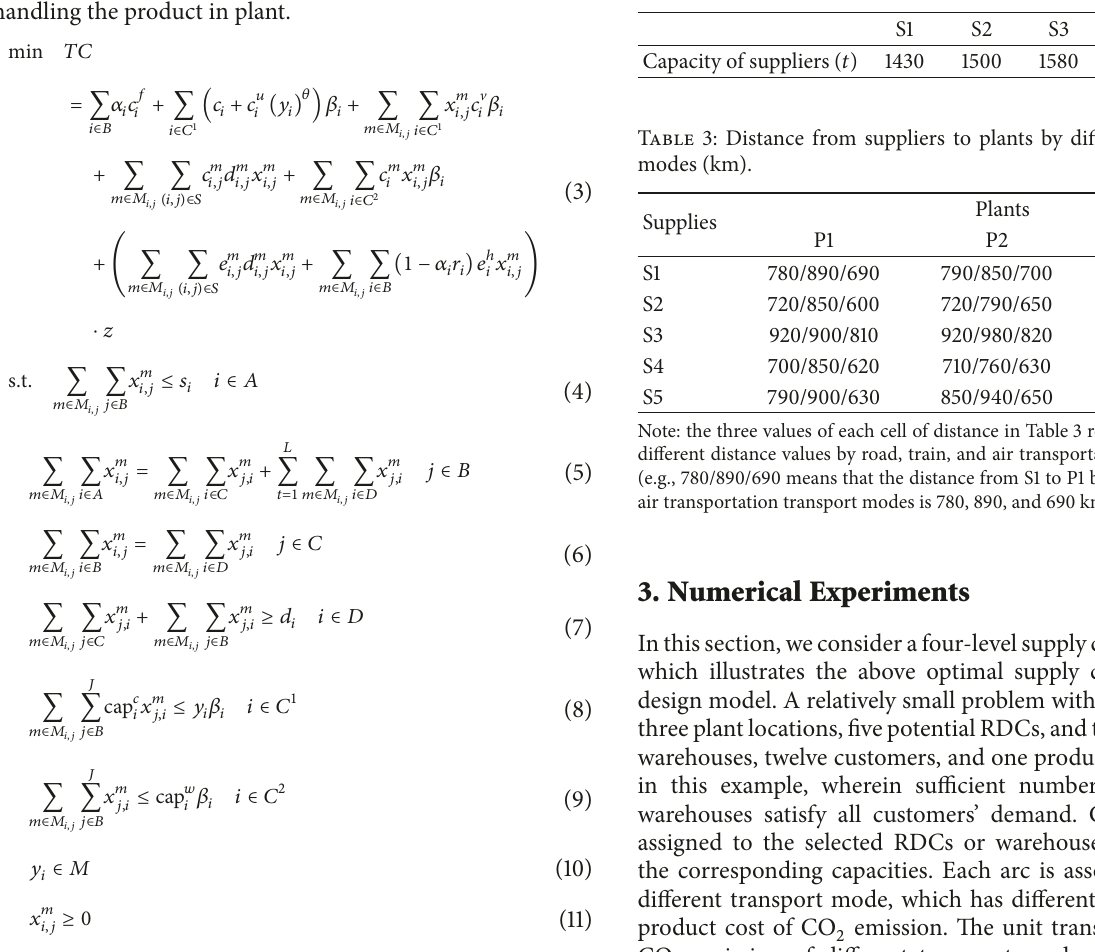
Table 2: Capacity of five suppliers.